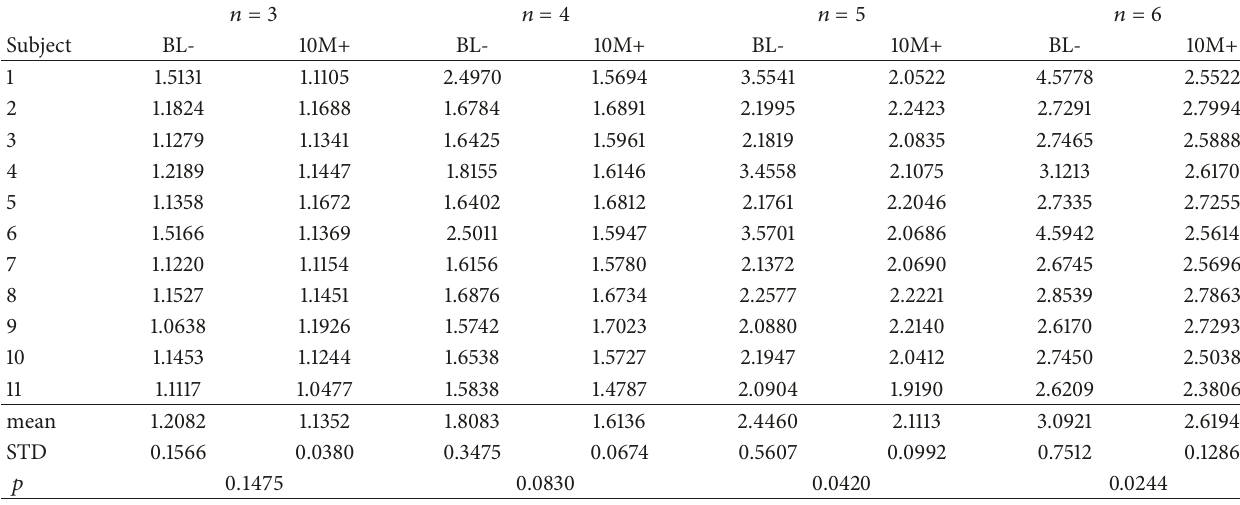
Table 6: Permutation Entropy individual, mean, and standard deviation (STD) values of the two classes studied, BL- and 10M+ for 𝑛 = 3, 4,5, 6 . No significant differences between groups were found in some cases (Wilcoxon signed rank test).